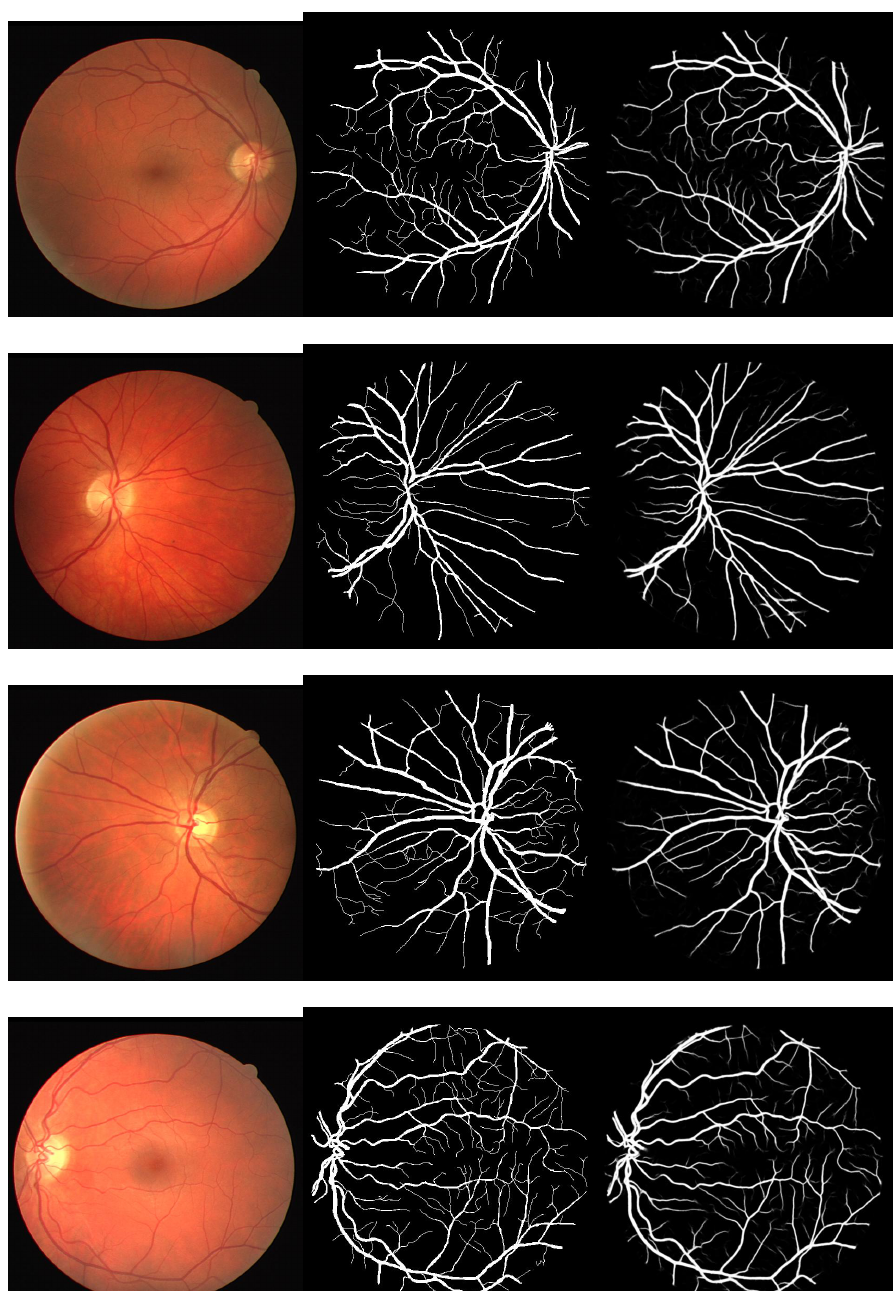
Figure 3. Sample images, their corresponding ground truth and the outcome of the proposed network while testing the DRIVE dataset (left to